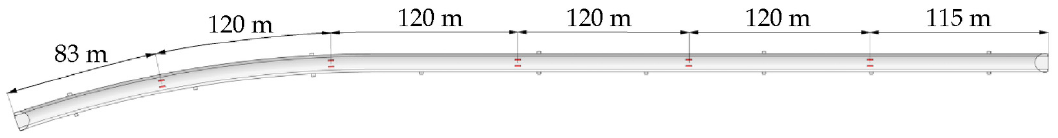
Figure 1. The overlay of the tunnel and location of the fans.